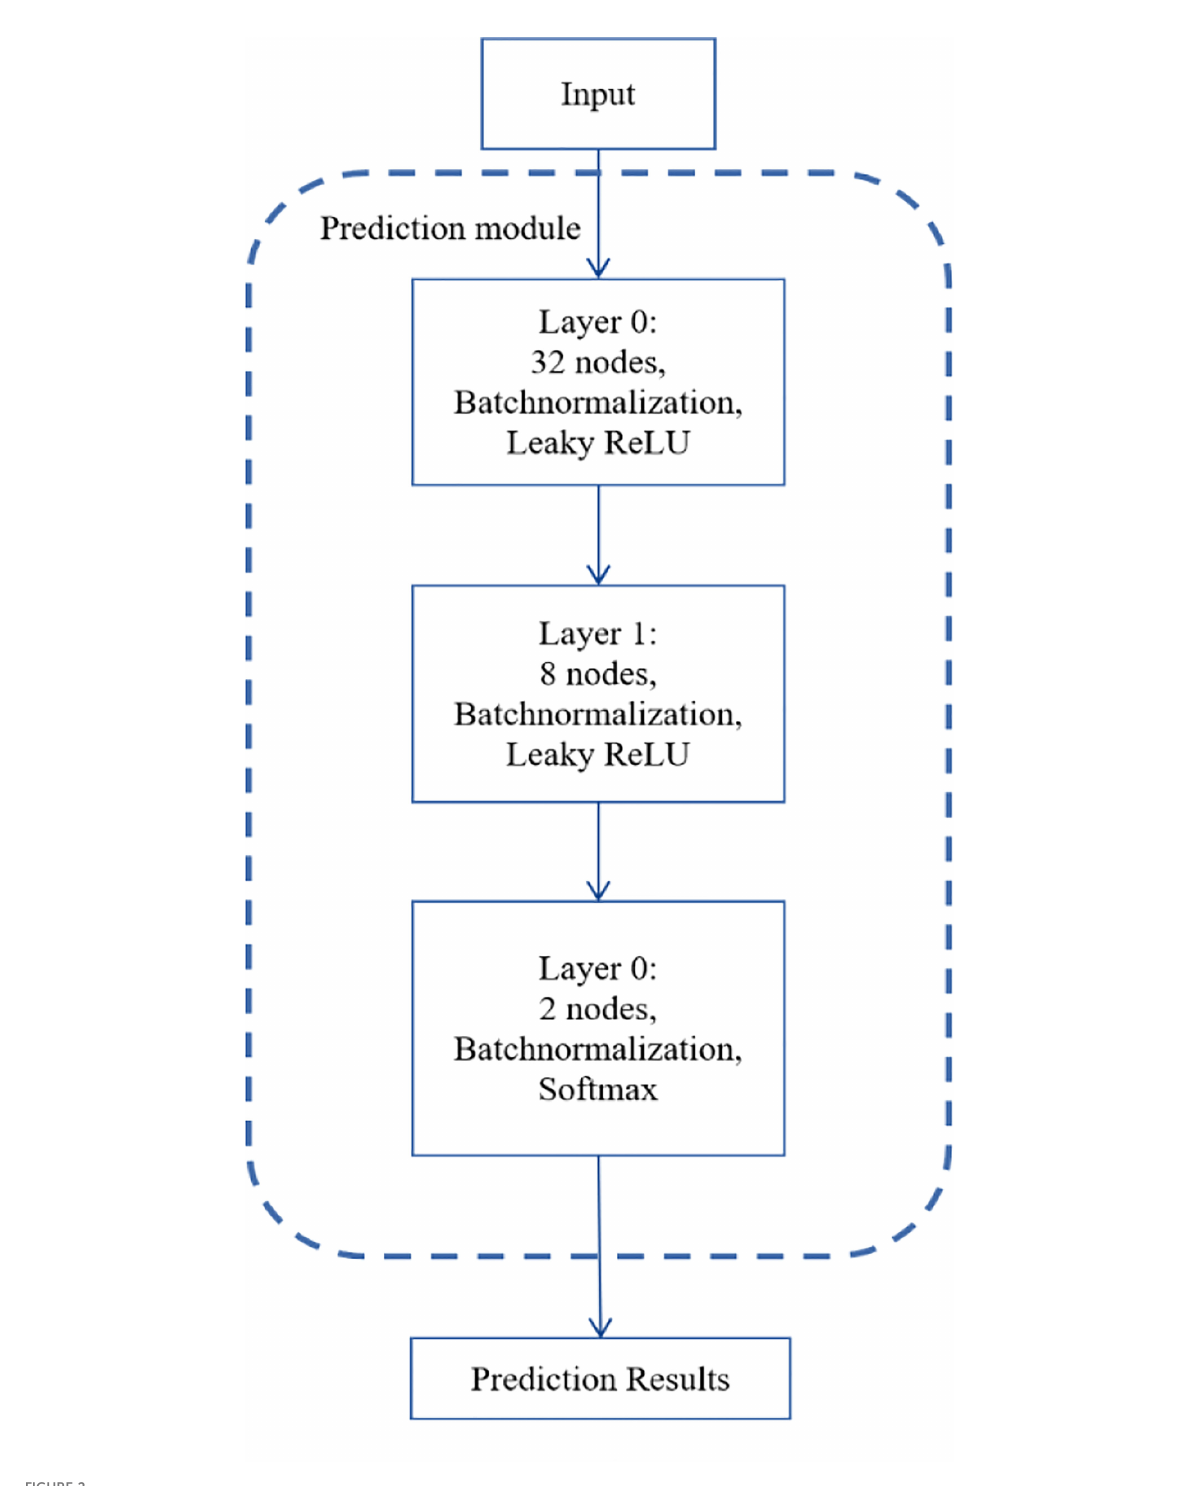
FIGURE 2 The structure of the DNN